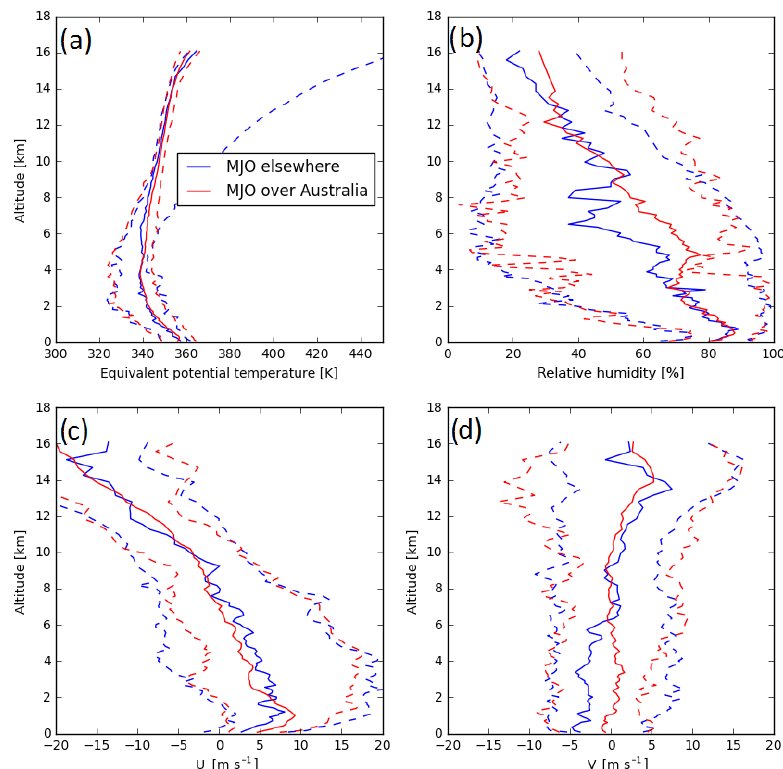
Figure 5. As in Fig. 4, but from 97 soundings taken during active monsoon conditions.